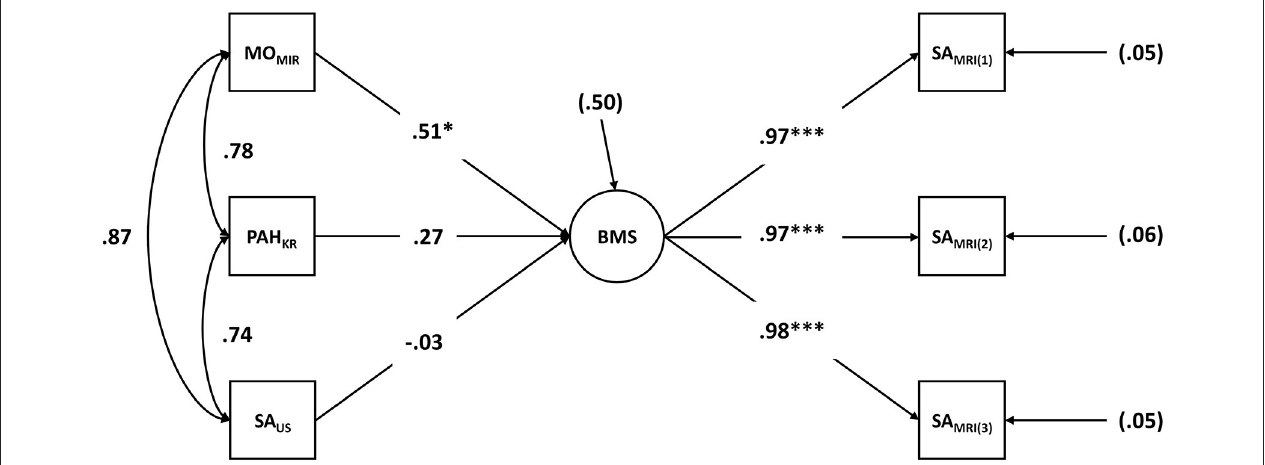
FIGURE 1 | Latent structural equation modeling (SEM): biological maturity status (BMS) as a latent construct predicted by the alternative BMS diagnostics. BMS lat , biological maturity status as a latent construct; SA MRI(i) , evaluation of skeletal age based on magnetic resonance imaging by rater i ; SA US , skeletal age determined by mobile ultrasound device; MO MIR , maturity offset according to Mirwald et al. (2002); PAH KR , percentage of adult height according to Khamis and Roche